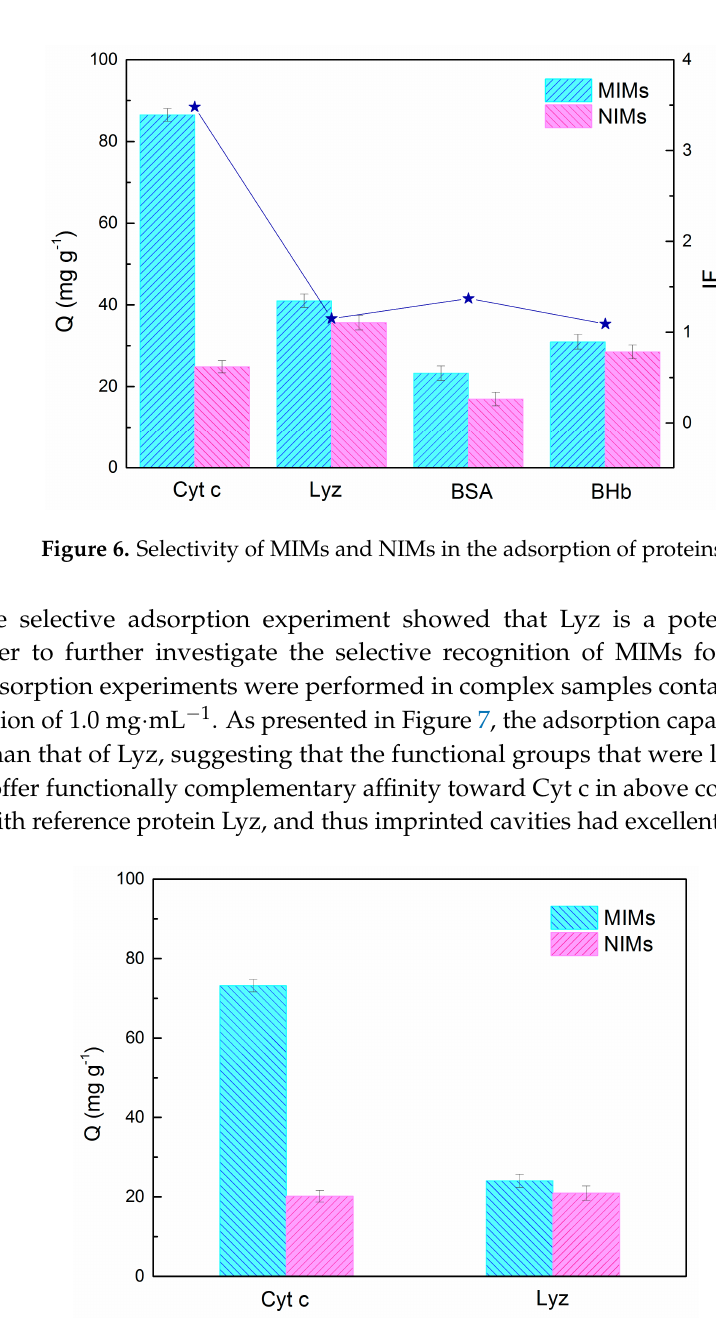
Figure 7. Selective binding of MIMs and NIMs for Cyt c and Lyz, respectively.